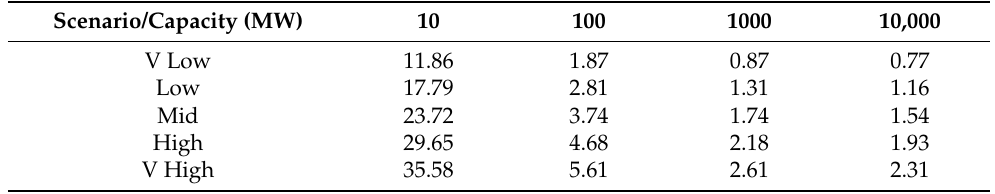
Table 9. LCOE Increase per